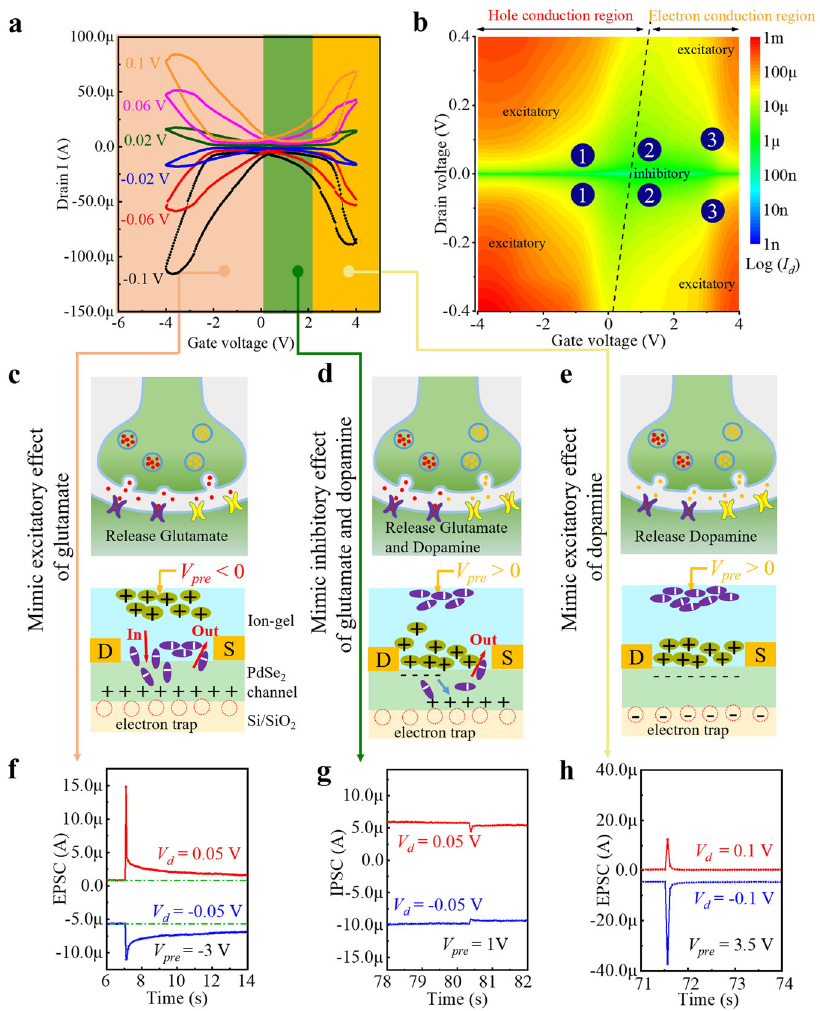
Fig. 3 A better understanding of dual-excitatory operation mechanism. a Dual-sweep I d − V g transfer curves of the device under V d = ±0.02, ±0.06, ±0.1 V. The entire working window can be divided into three regions corresponding to a glutamate-independent excitatory effect region, a glutamate-and-dopamine synergistic inhibitory effect region, and a dopamine-independent excitatory effect region, respectively. b The current measured at the drain electrode was plotted as a function of V d and V g ; the color in the I − V contour map represents the amplitude of log( I d ) and the three regions are clearly distinguished by the color. c Anions in the ion gel simulated the glutamate. Application of a negative presynaptic spike V Pre induce holes accumulation in the conduction channel, and hole current represents glutamatergic postsynaptic current. d Hole-current decrease induced by electrons progressively neutralizing holes represents the inhibitory effect between glutamate and dopamine. e Cations in the ion gel simulate dopamine. Continuing application positive presynaptic spikes induces electrons accumulation in the conduction channel; electron-current represents dopaminergic postsynaptic current. f EPSCs in response to a − 3 V input pulse were read with the polarity opposite reading voltages. g IPSCs in response to a relatively small positive 1 V input pulses were read with the polarity opposite reading voltage. h The EPSCs in response to a large enough positive 3.5 V input pulse were read with the polarity opposite reading